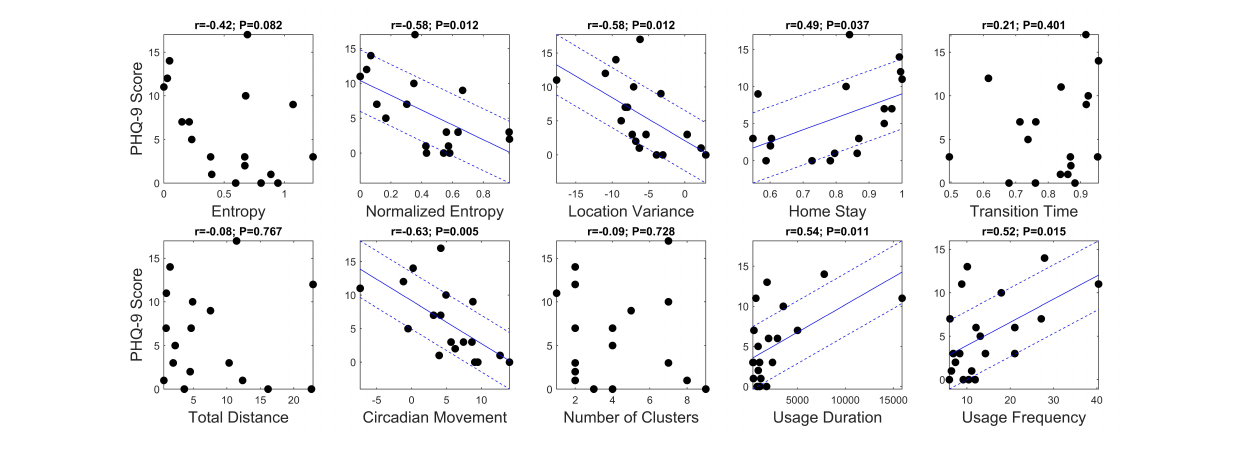
Figure 3. Scatter plots for location and phone usage data versus PHQ-9 scores, respectively. The coefficient of correlation between each feature and PHQ-9 scores and its corresponding P-value is shown on top of each plot. Solid and dashed lines, shown only for strong correlations ( P <.05), show the fitted regression model and +/- root mean square deviation from the model,